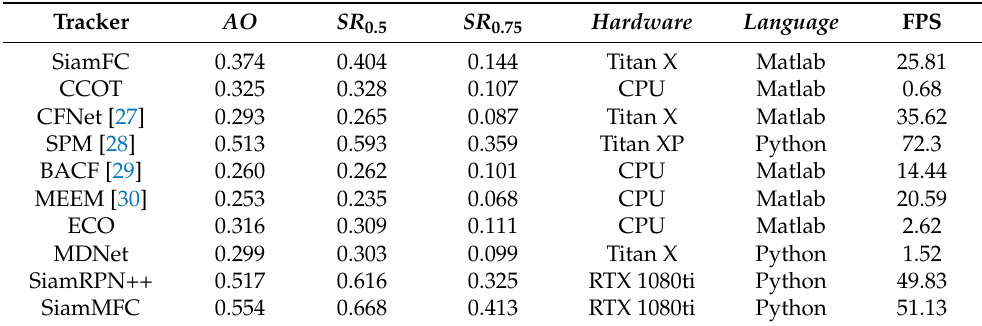
Table 2. Comparison results on GOT-10k benchmark.